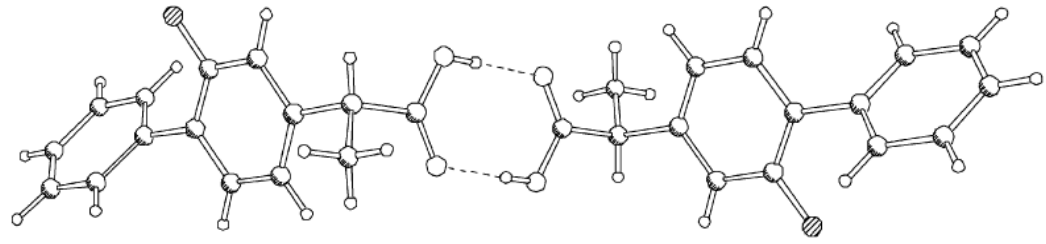
Figure 20. Hydrogen bonded dimer of flurbiprofen (Form 1) based on the published X-ray structure [106], but with adjustment of the hydrogen atoms as obtained by computation. Reprinted, with permission, from [105]. Copyright 2005, The Royal Society of Chemistry. Table 2. Comparison of the bond lengths involving hydrogen atoms of the X-ray, hydrogen-optimized and fully optimized structures of flurbiprofen. Reprinted, with permission, from [105]. Copyright 2005, The Royal Society of Chemistry.